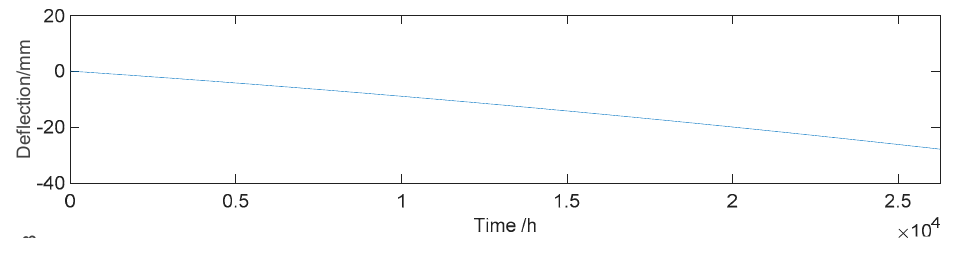
Figure 9. Deflection effect of the prestress loss ( D p ).